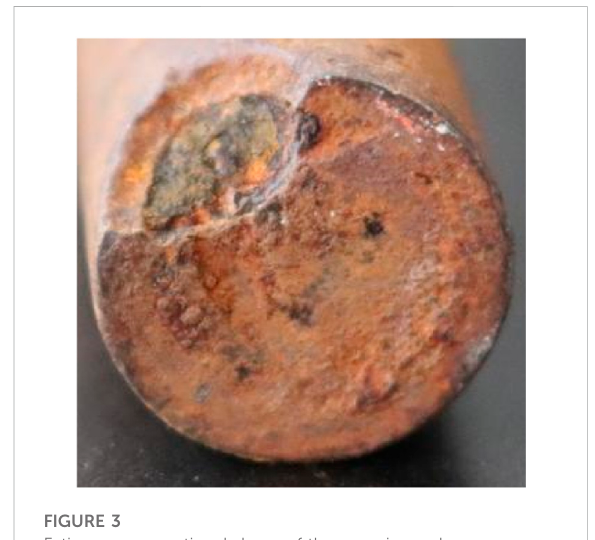
FIGURE 3 Fatigue cross-sectional shape of the pumping rod.